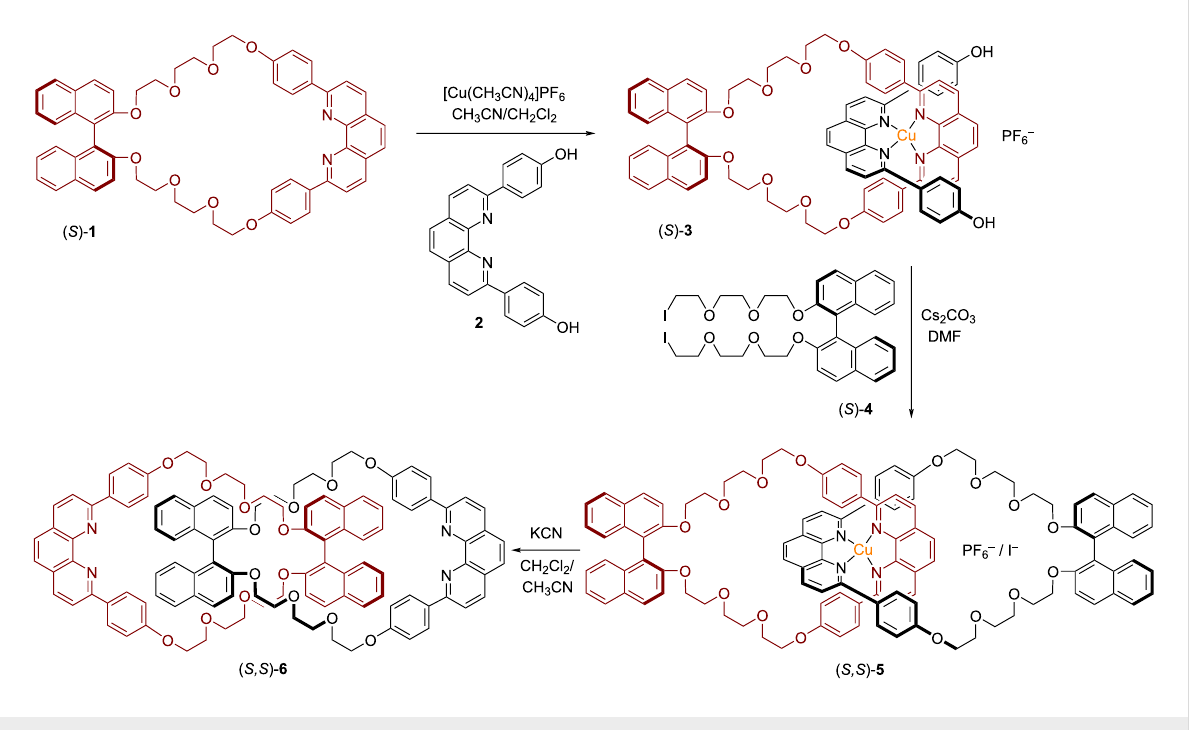
Figure 2: Synthesis of Sauvage´s [2]catenanes ( S,S )- 5 and ( S,S )- 6 containing two BINOL units by the passive metal template method.